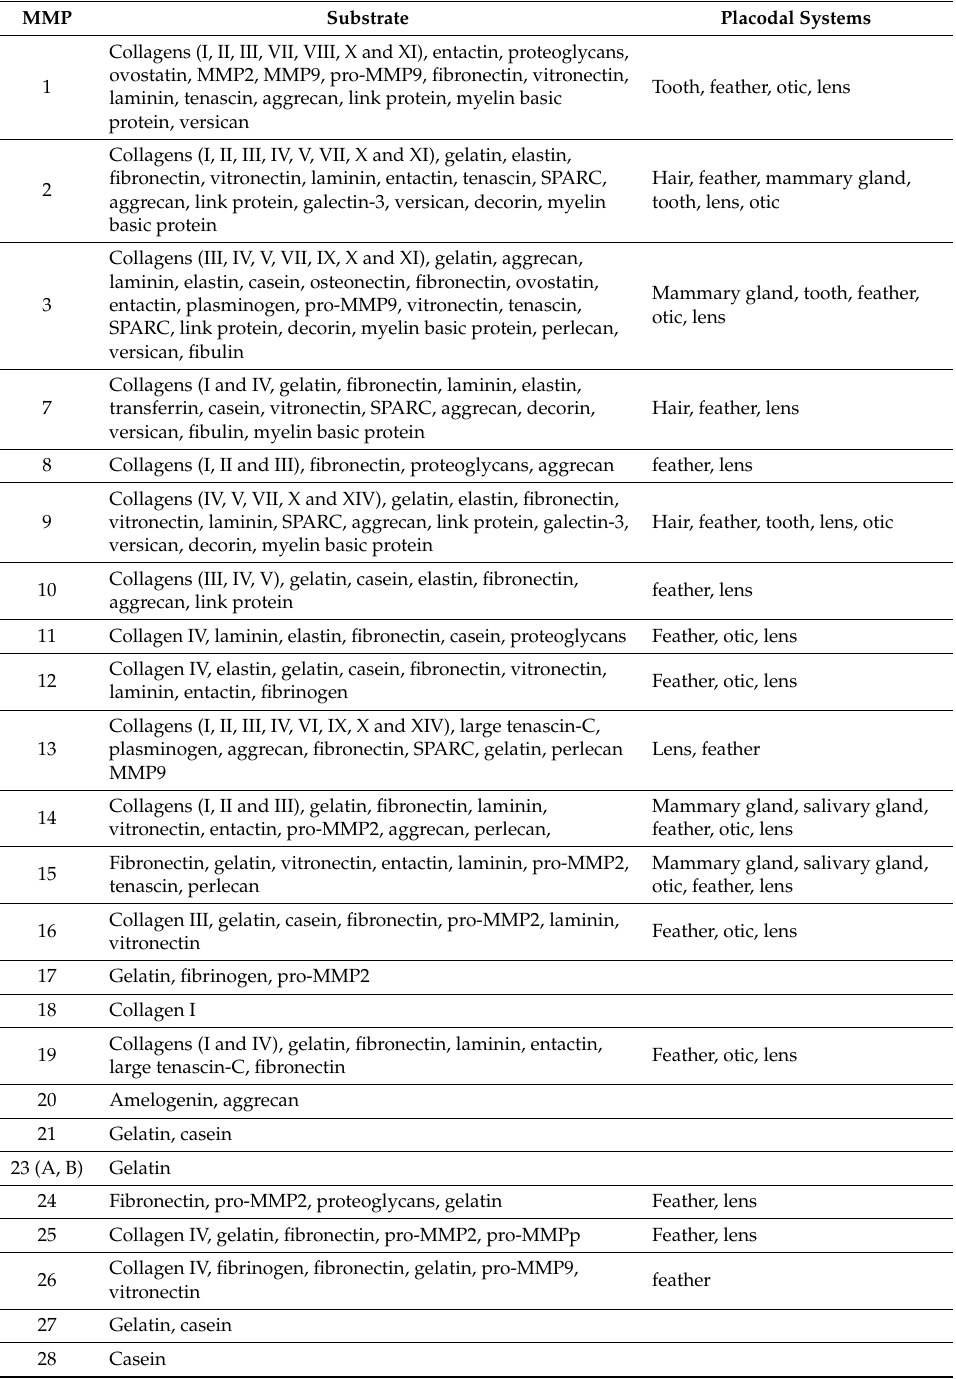
Table 1. Matrix metalloproteinases (MMPs), their known extracellular matrix substrates, and the placodal systems in which their substrates have been studied. Modified from Reference